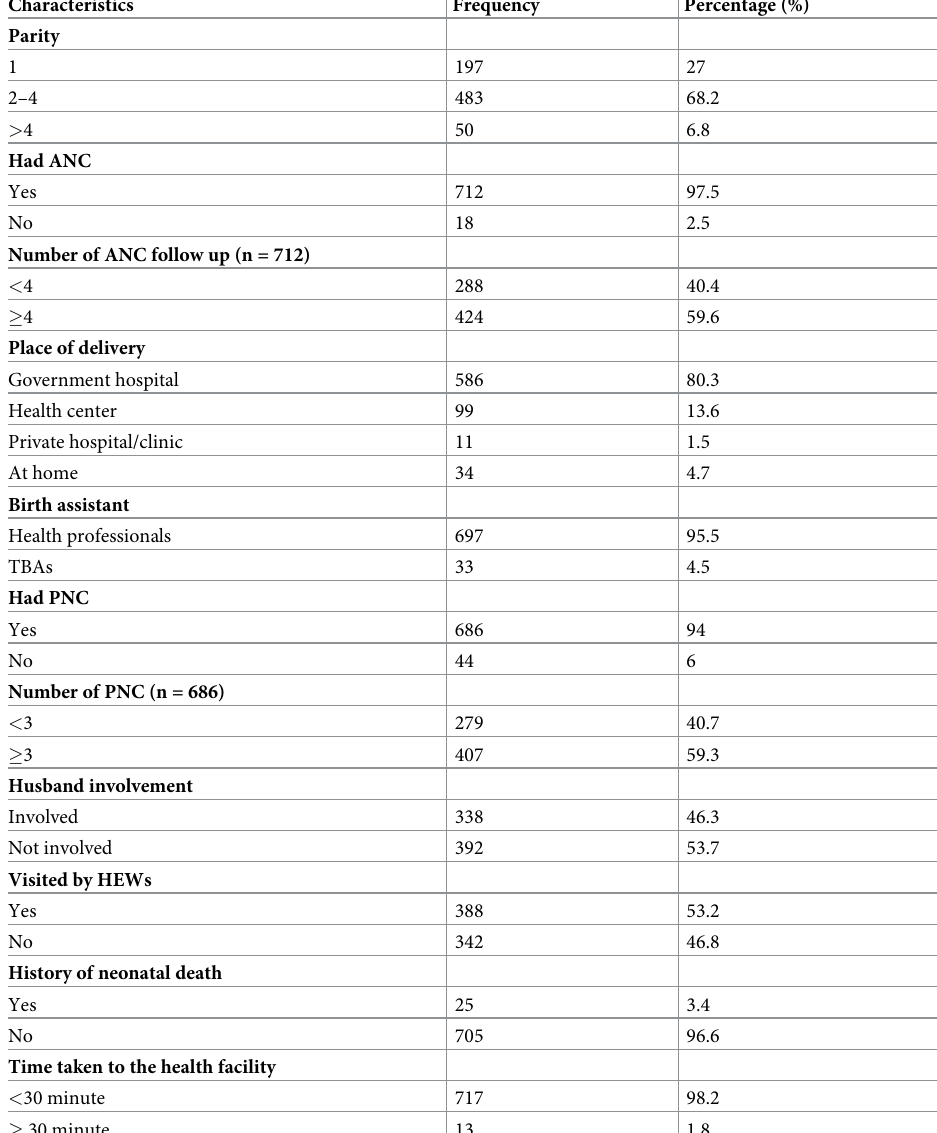
Table 2. Reproductive history and maternity healthcare service-related characteristics of study participant in Debretabor, Northwest Ethiopia, 2019 (n = 730).